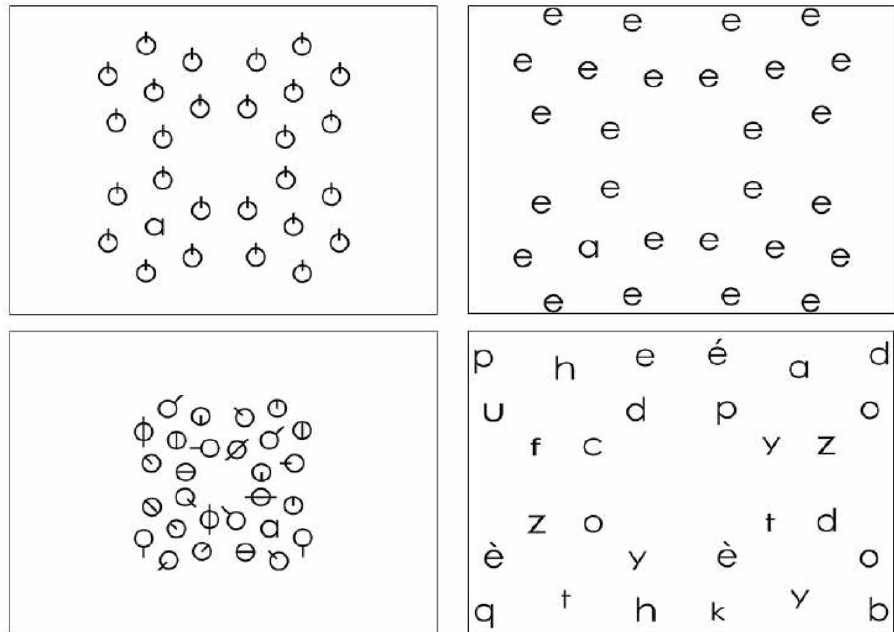
Figure 1. Visual search training using symbols. Four examples of visual displays (presented alone on the entire screen) where the child had to find the target letter “a” among four different types of visual distracters in four blocked training sessions: symbols all similar (top left), letters all similar (top right), symbols all different (bottom left), letters all different (bottom right).